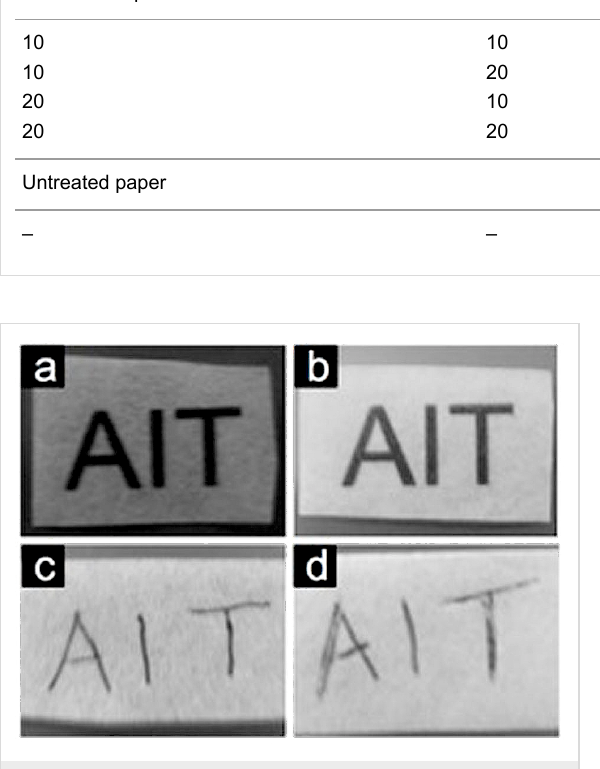
Figure 8: (a) Ink-jet printed text on untreated paper and (b) ink-jet printed text on paper coated with ZnO nanorods (20 mM / 20 h). (c) Text written with a ball-point pen on untreated paper and (d) text written with ball-point pen on paper coated with ZnO nanorods (20 mM / 20